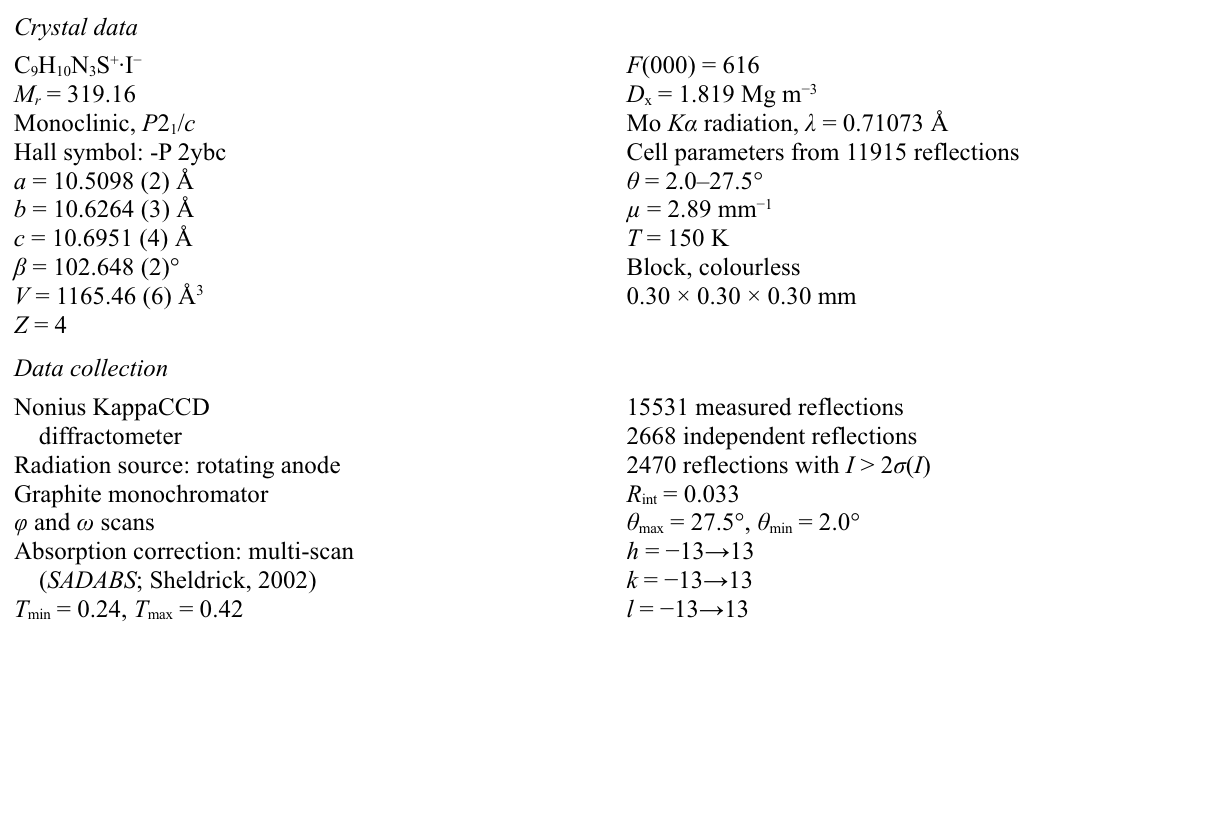
Figure 3 C—H··· π interaction in (I). View along the crystallographic b axis. Symmetry operation i: x , 0.5 - y , z - 1/2. Indole-3-thiouronium